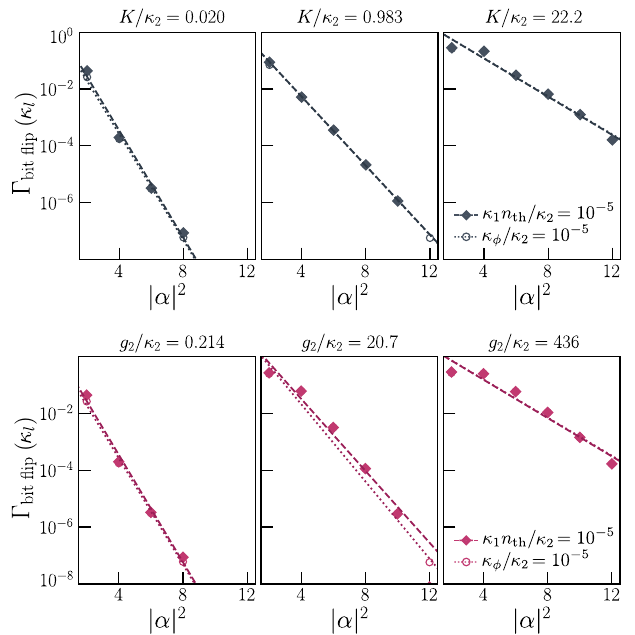
FIG. 16. Bit-flip error rate of an idling cat qubit with a com- bined Kerr (top) or TPE (bottom) and two-photon dissipation confinement. for increasing values of K /κ 2 and g 2 /κ 2 . Both sim- ulation data points (markers) and exponential fits of these data points (lines) are shown. The exponential suppression factor γ plotted in Fig. 7 is extracted from such exponential fits. The cat qubit is subject to single-photon loss at rate κ 1 /κ 2 = 10 − 3 and either thermal excitations at rate κ 1 n th /κ 2 = 10 − 5 (diamonds) or pure dephasing at rate κ φ /κ 2 = 10 − 5 (circles). Bit-flip error rates are plotted with respect to the leakage rate κ l = κ 1 n th + | α | 2 κ φ .